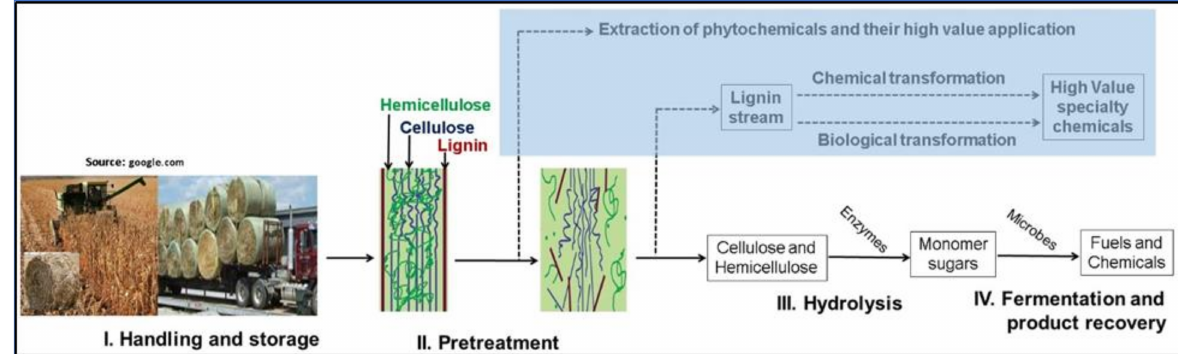
Figure 2. Integrated lignocellulosic biomass conversion through sugar platform route. The shaded portion shows the potential paths to valorize under-utilized streams of the process